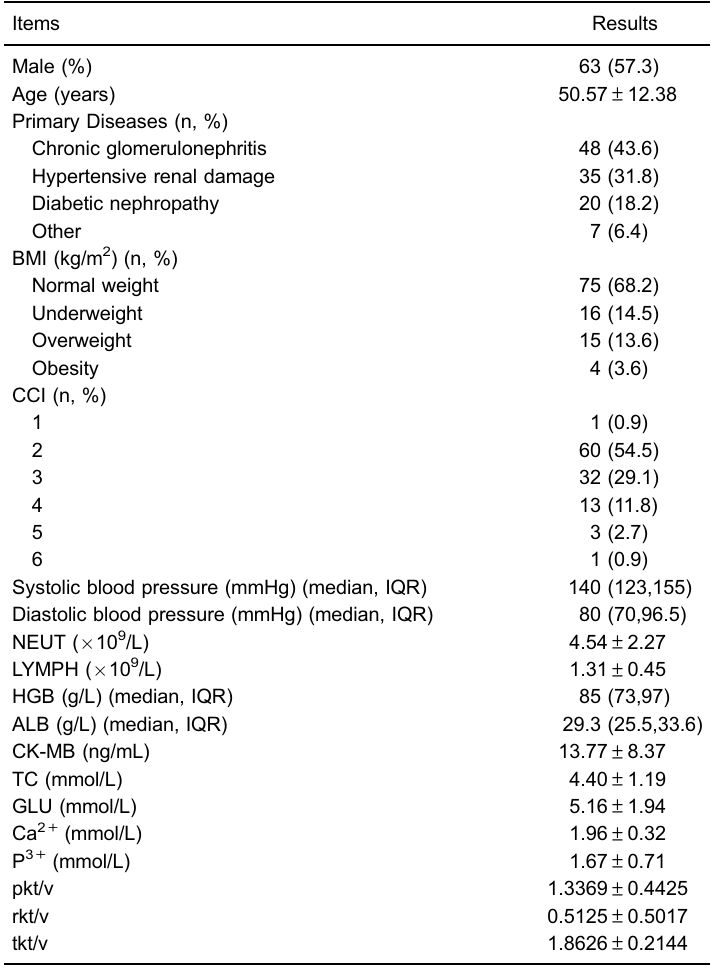
Table 1. Demographic characteristics of patients treated with urgent-start peritoneal